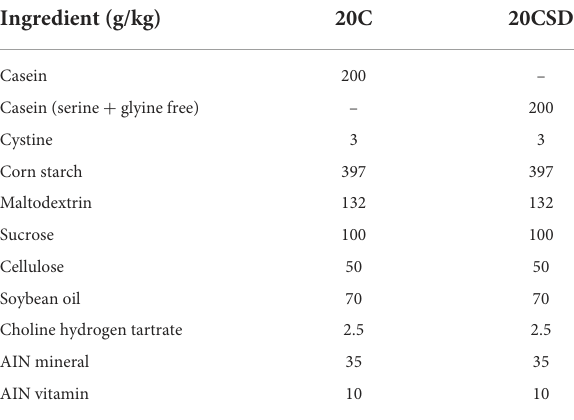
TABLE 1 Two groups of feed